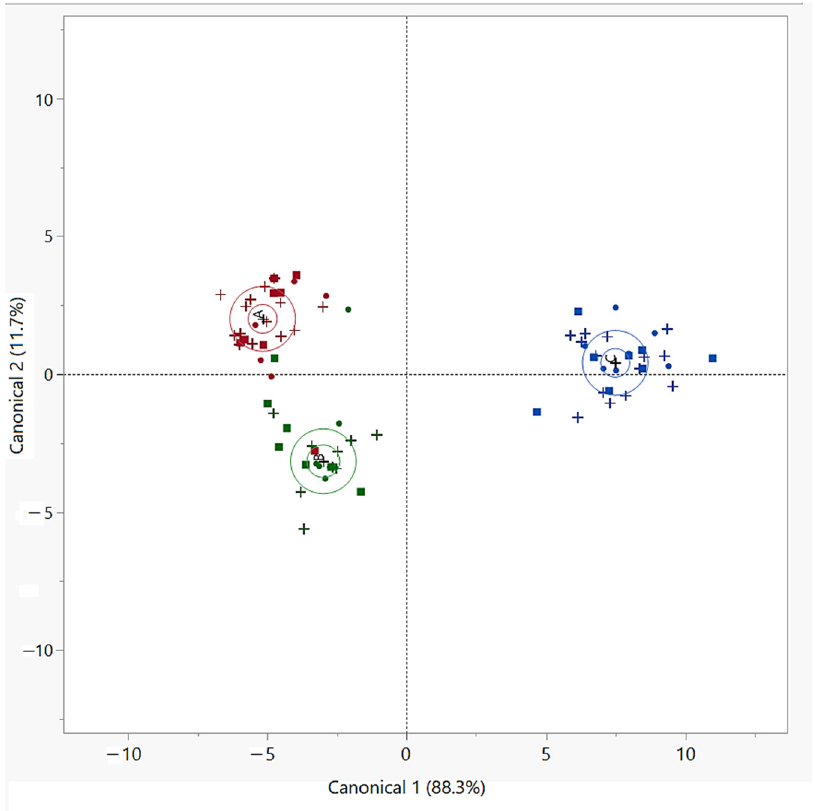
Figure 1. Canonical plot of the linear discriminant analysis performed on cheese samples, grouped by farm (O, M, C), using milk samples from Lopez et al. [22] as training set. In the plot, each group is associated with a 95% confidence ellipse for the mean and a 50% prediction ellipsoid. Legend: red = Farm O (organic-certified farm); green = Farm M (mountain farm); blue = Farm C (conventional lowland farm); + = milk; ■ = fresh cheese; ● = semi-hard cheese.